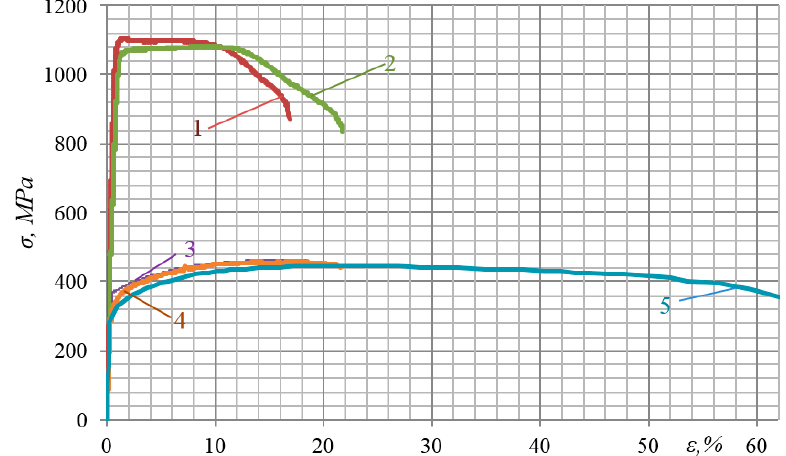
Figure 2. Stress-strain diagrams of materials: 1—Titanium alloy VT23; 2—titanium alloy VT23M; 3—aluminum alloy 2024-T351; 4—aluminum alloy D16ChATW; 5—stainless steel 12Kh17.